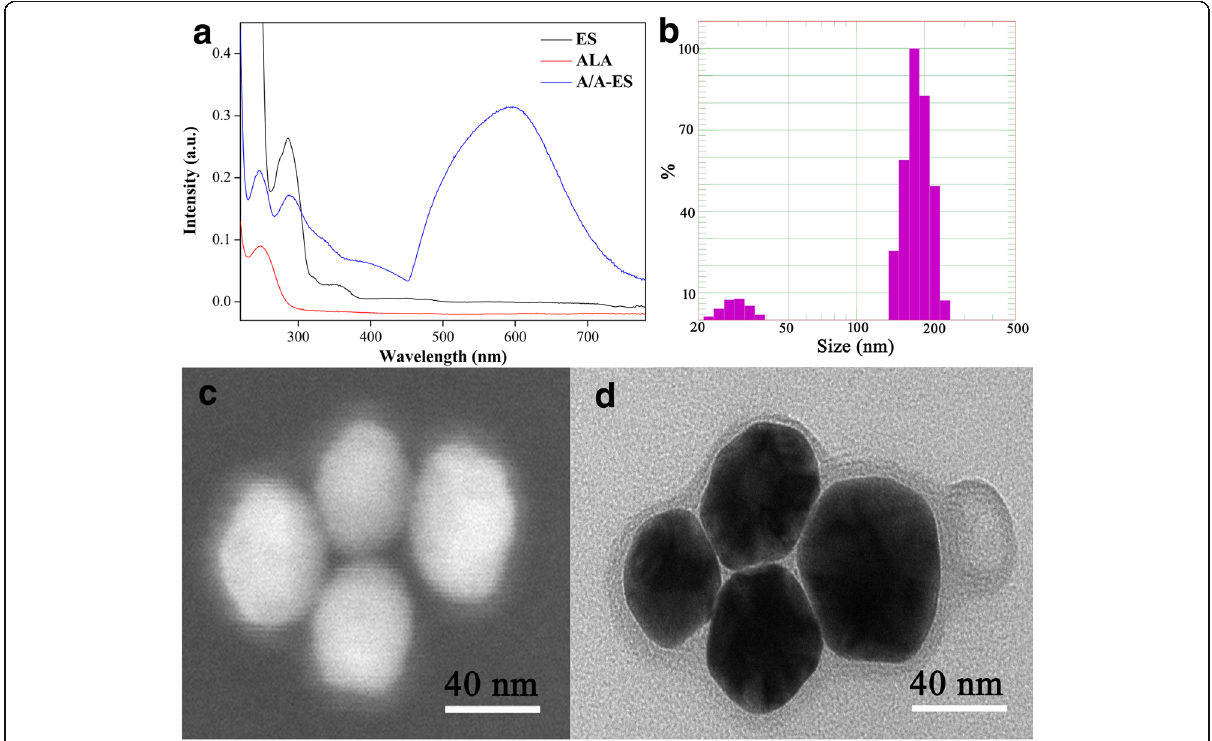
Fig. 1 a UV-Vis spectra of ES, ALA, and A/A-ES. b The size distribution of prepared A/A-ES. c , d The SEM and TEM images of